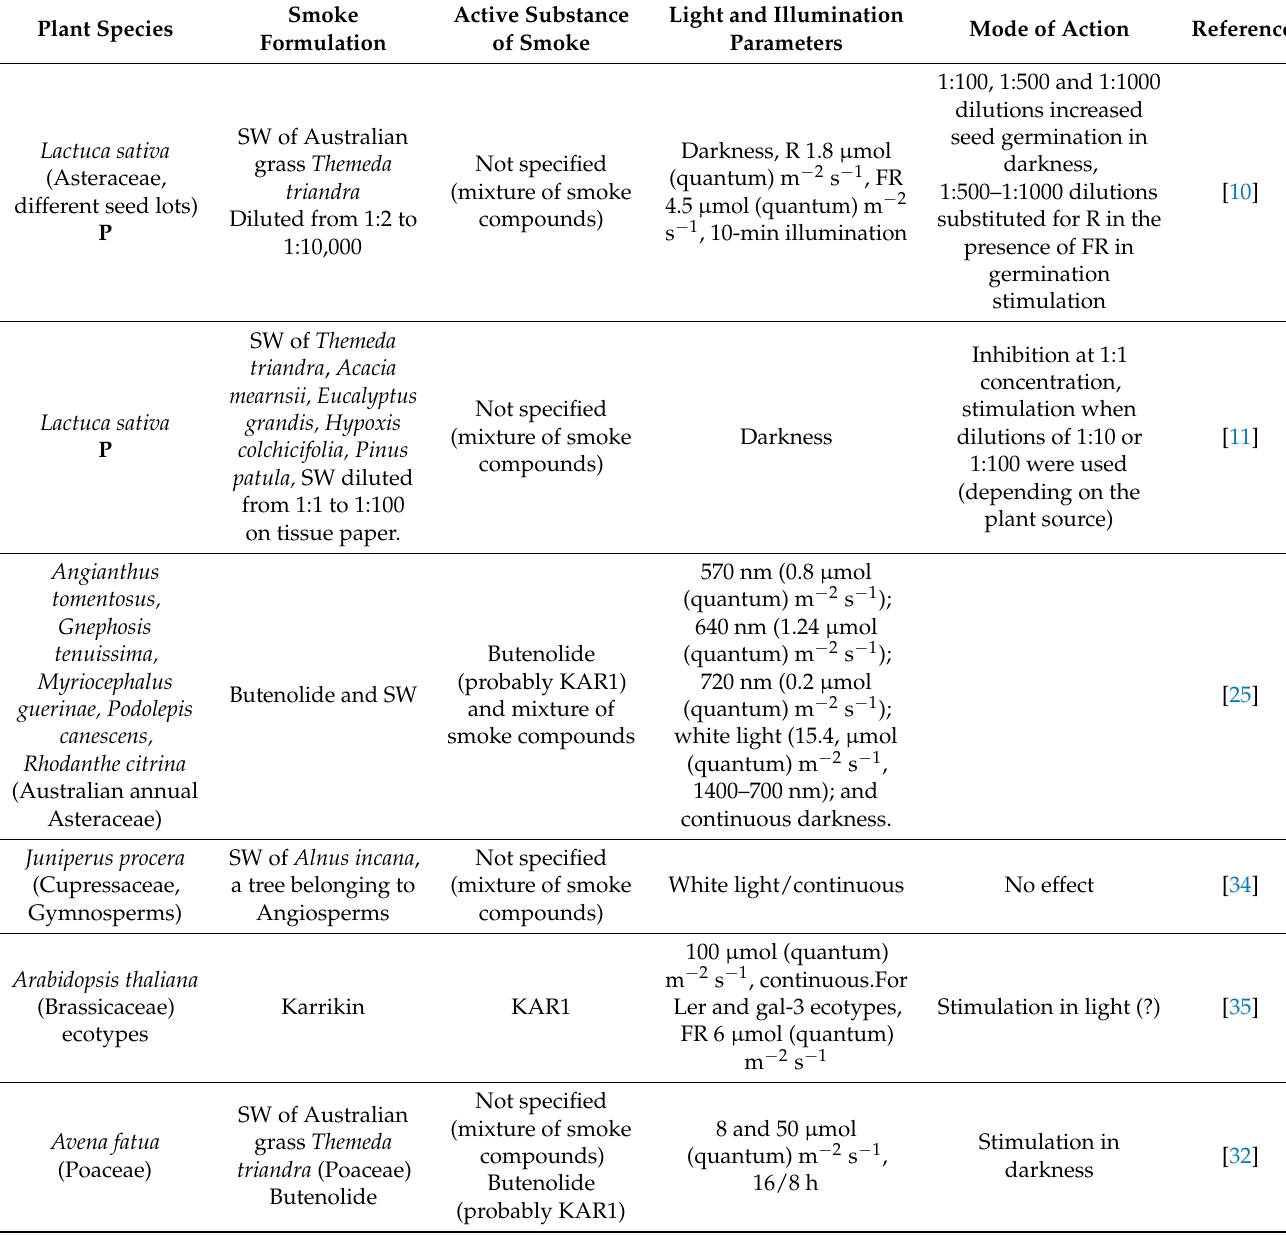
Table 1. Germination response of seeds treated with different forms of smoke compounds (chrono- logical order). P—positively; N—negatively photoblastic seeds. Some species respond to light during germination but these are not defined as